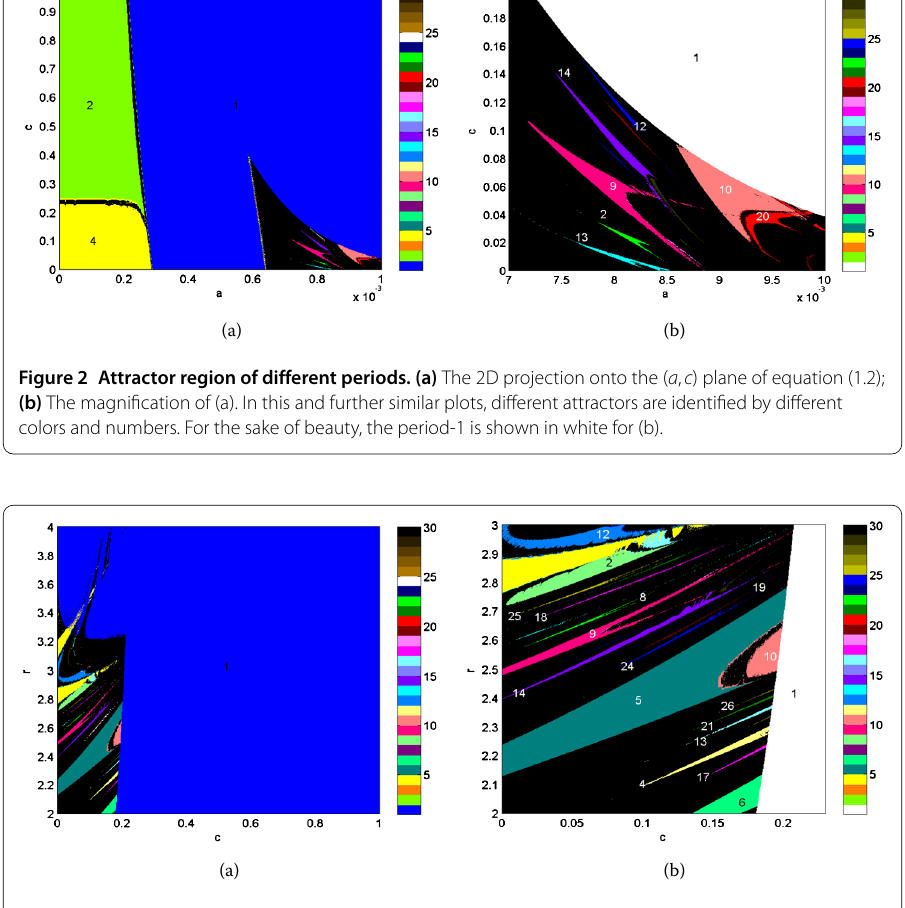
Figure 3 Attractor region of different periods. (a) The c × r parameter plane of equation (1.2); (b) Local amplification of (a) for c ∈